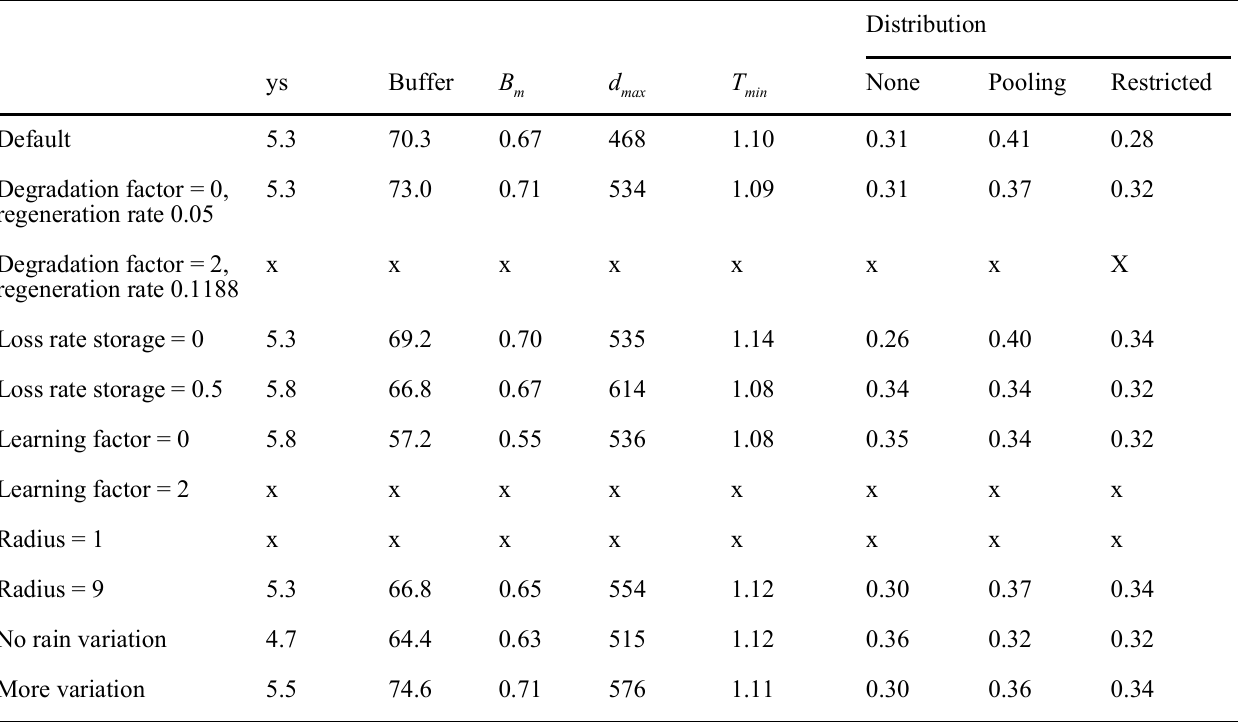
Table 5. Average values of the evolved parameters during the last 1,000 time steps. Based on 100 simulations of 10,000 time steps. Rows with an x indicate that less than 5% of the simulations did not collapse before 9,000 time steps, and thus, no data could be derived.